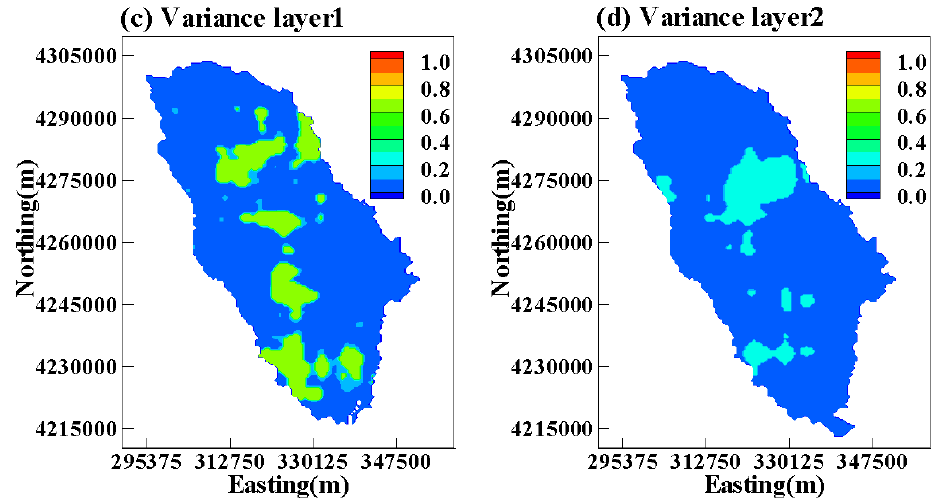
Figure 9. The multi-model ensemble mean and variance of log hydraulic conductivity for each layer after 36 steps of data